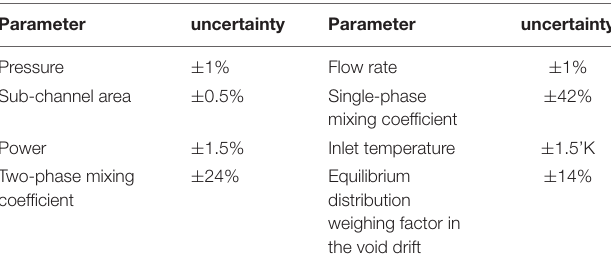
TABLE 6 | Uncertainties in